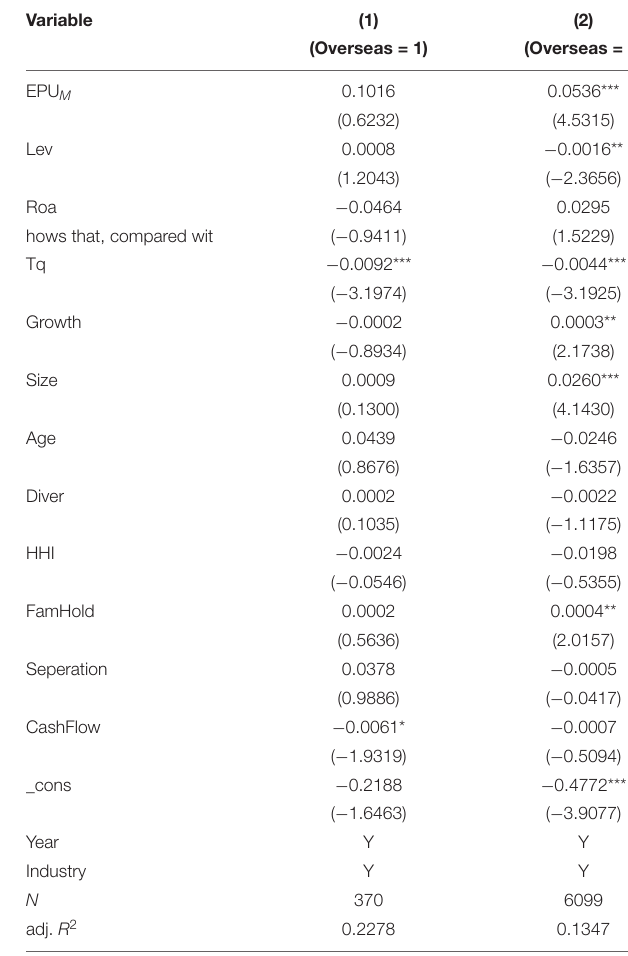
TABLE 2 | Basic regression. TABLE 3 | Group inspection of family firm’s executives with overseas